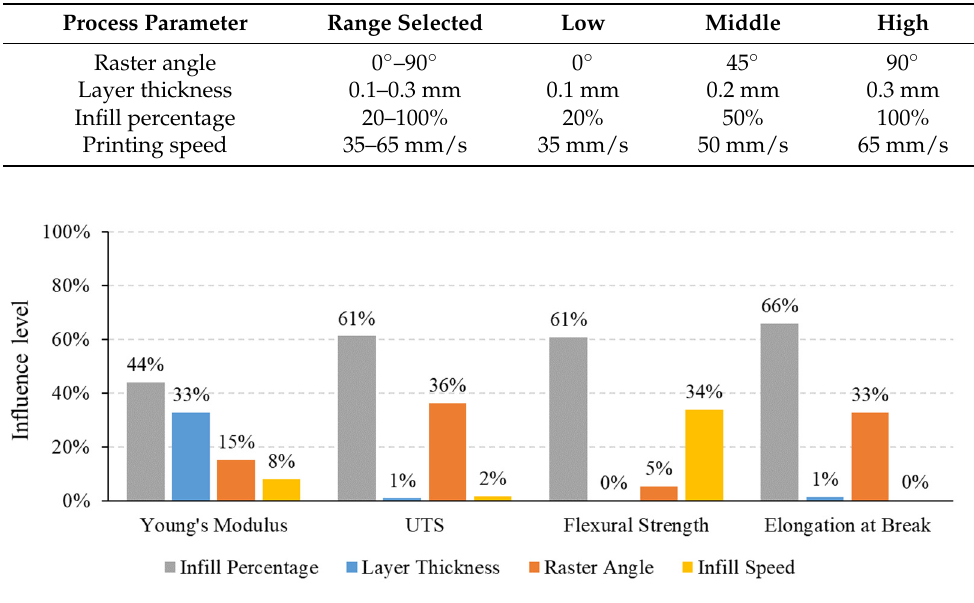
Figure 5. Process parameter’s relative influence on PLA mechanical properties. Table 3. Table ranking parameters according to influence on PLA mechanical properties as deter- mined by